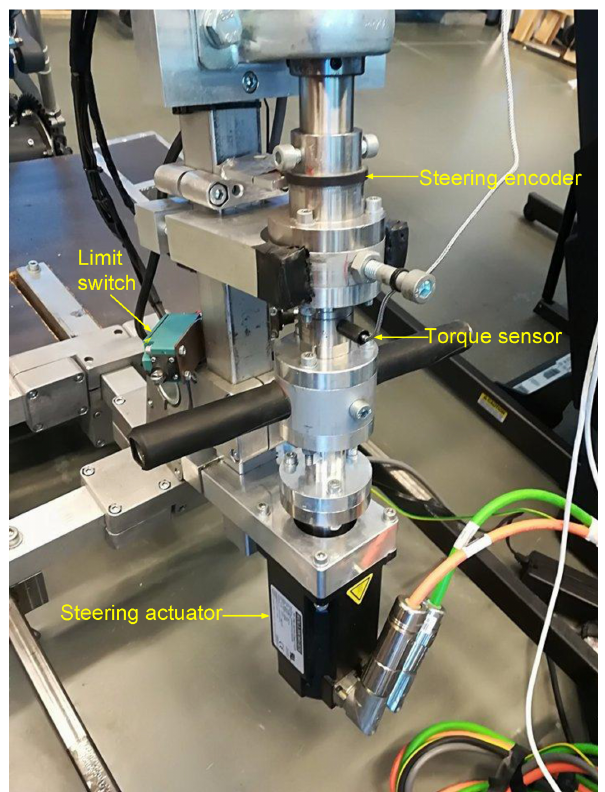
Figure 5. Steering shaft